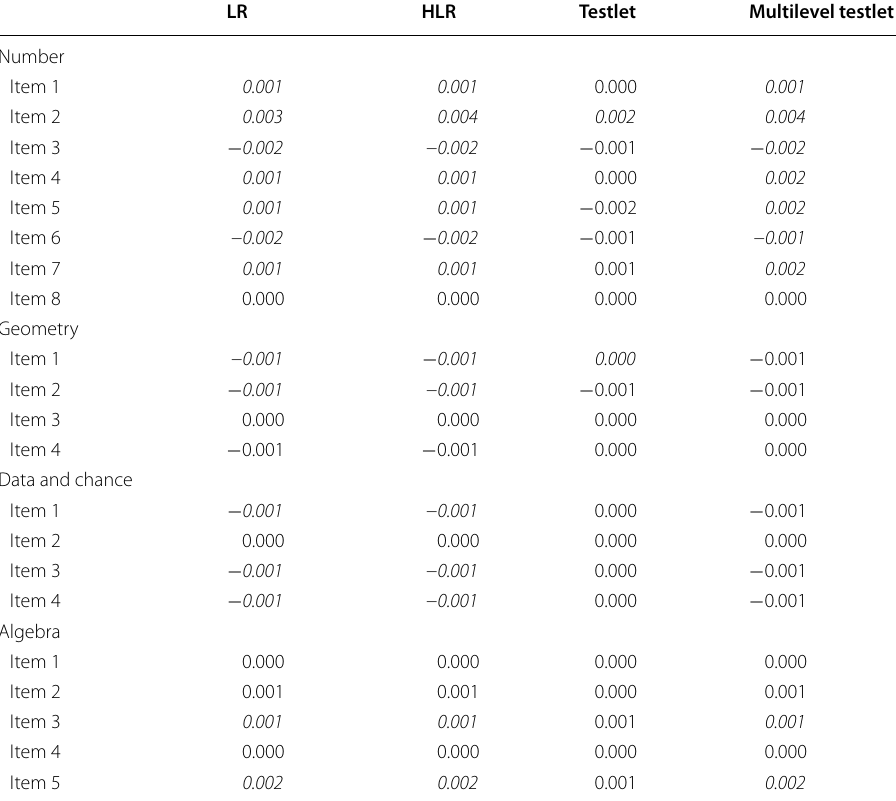
Italised DIF parameter estimates are significant at 5